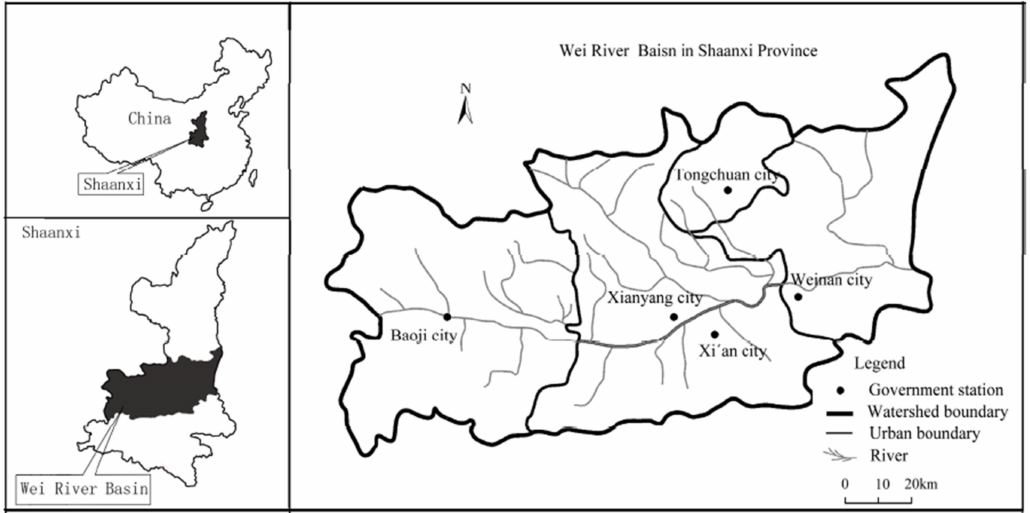
Figure 1. Map of the study